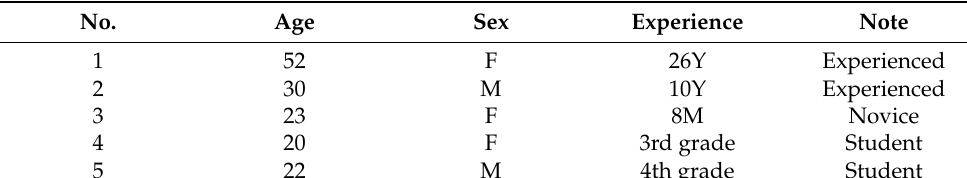
Table 1. Characteristics of the participants.